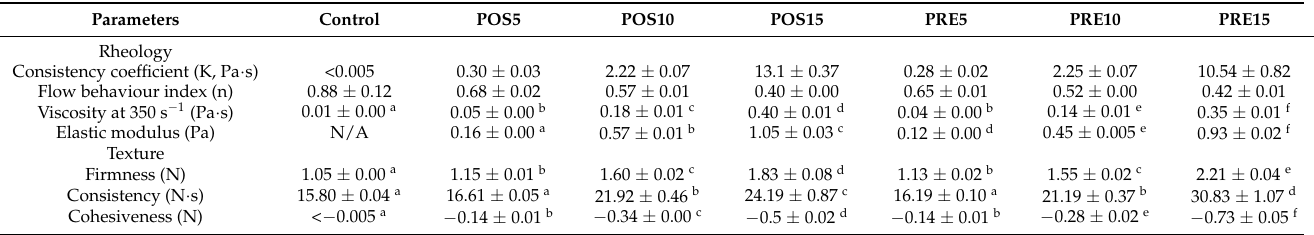
Table 2. Rheological and textural parameters of yoghurt